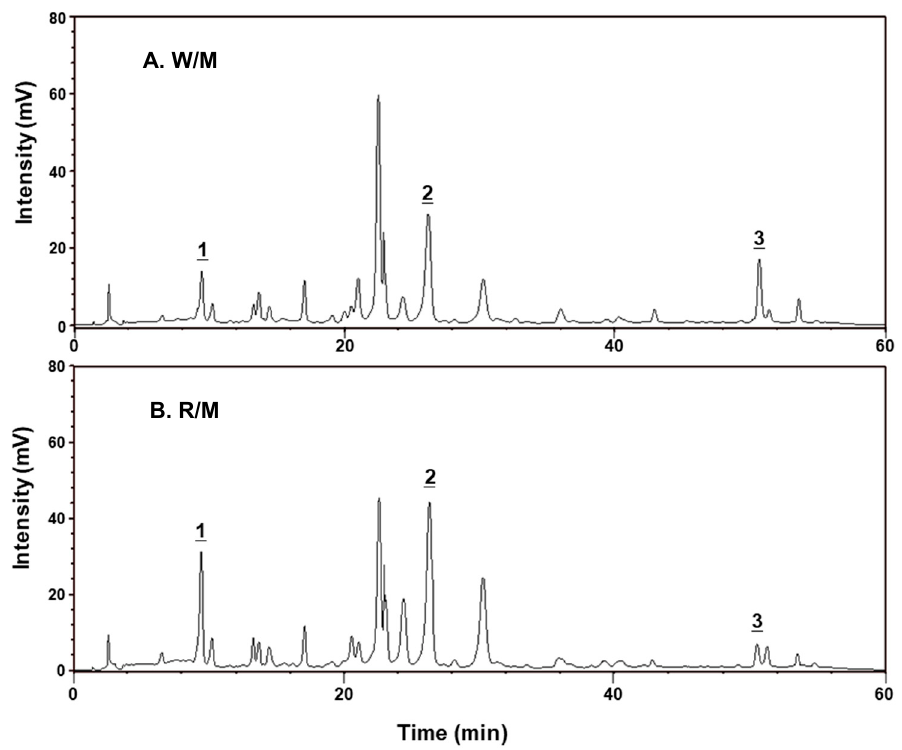
Figure 6. HPLC chromatogram of the W/M GTE ( A ) and R/M GTE ( B ). The mobile phase was methanol/0.05% acetic acid (4:6, v / v ) with the flow rate of 1.0 mL/min. The detection was performed at 350 nm. Identified components: 1, chlorogenic acid; 2, luteolin-7-glucoside; and 3, luteolin. Table 1. Main ingredients analysis of the W/M GTE and R/M GTE *.